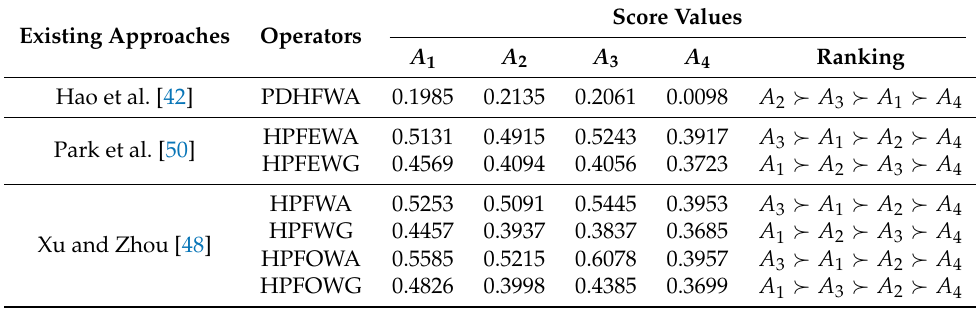
Table 6. Comparison of overall rating values and ranking order of alternatives.